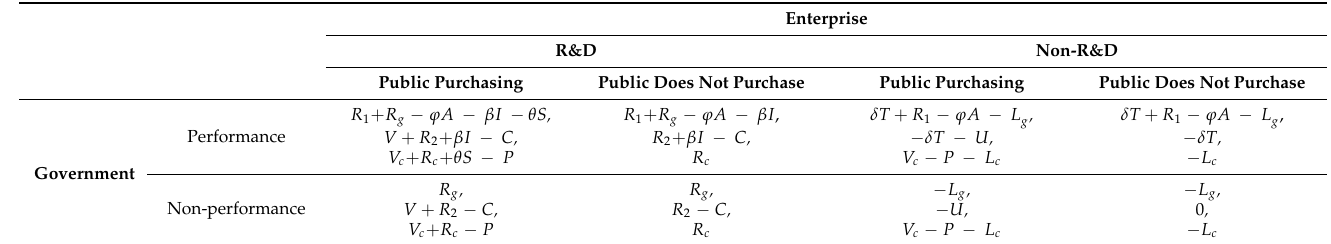
Table 3. “Government–enterprise–public tripartite” income